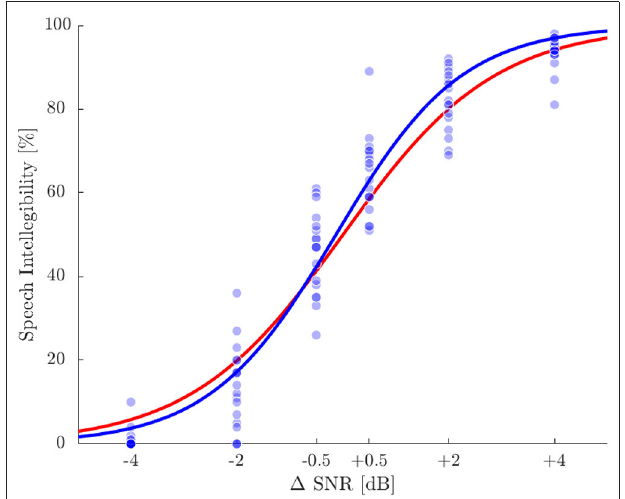
FIGURE 2 | Speech intelligibility in percentage for the six 1 SNR conditions. Blue dots represent single measurements and the blue line displays a sigmoid function fitted to the single values. The red line represents the reference function according to Wagener et al. (1999c).